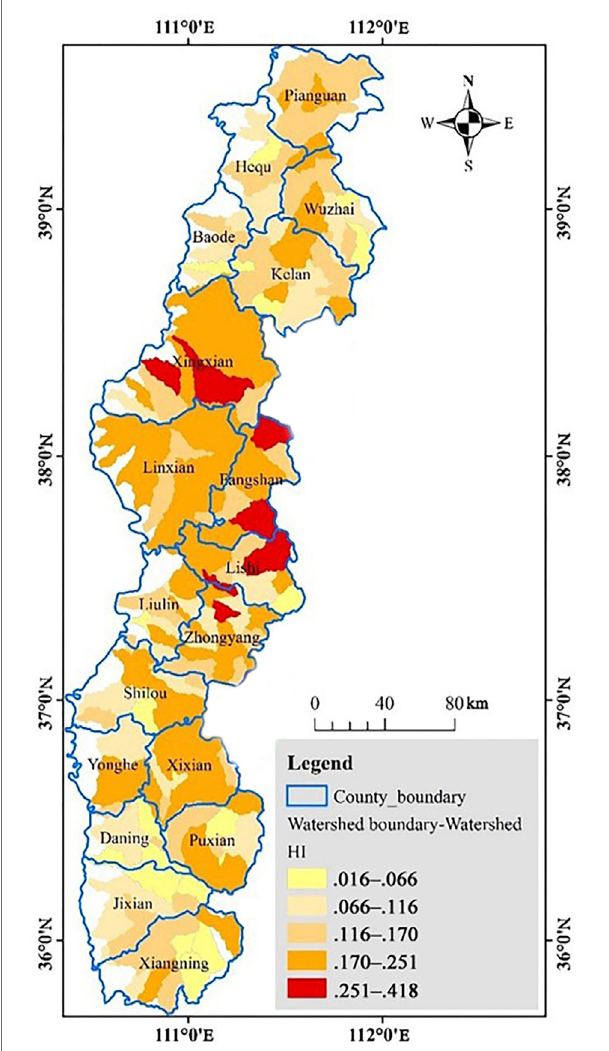
FIGURE 9 | Map of the spatial differentiation of the hypsometric integral (HI) of the watershed boundary-watershed.